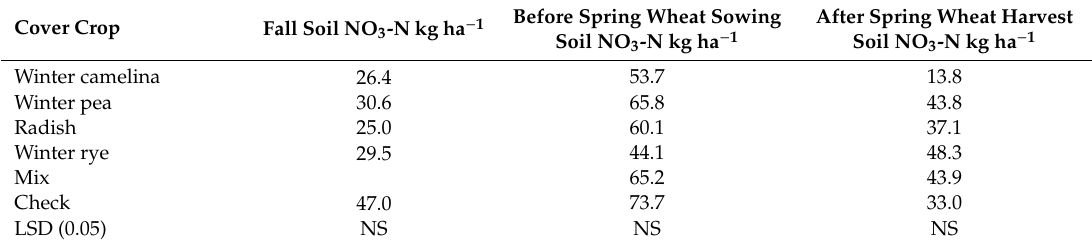
Table 7. Mean soil NO 3 -N levels in the fall, before spring wheat sowing, and after spring wheat harvest for five cover crop treatments averaged across two cover crop sowing dates and four environments at Fargo and Prosper, ND, from 2017 to